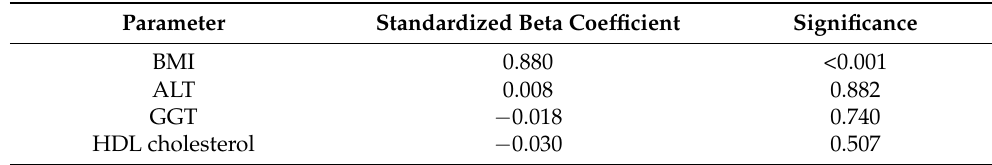
Table 4. Multiple regression analysis for fat mass (FM) and selected parameters; BMI—body